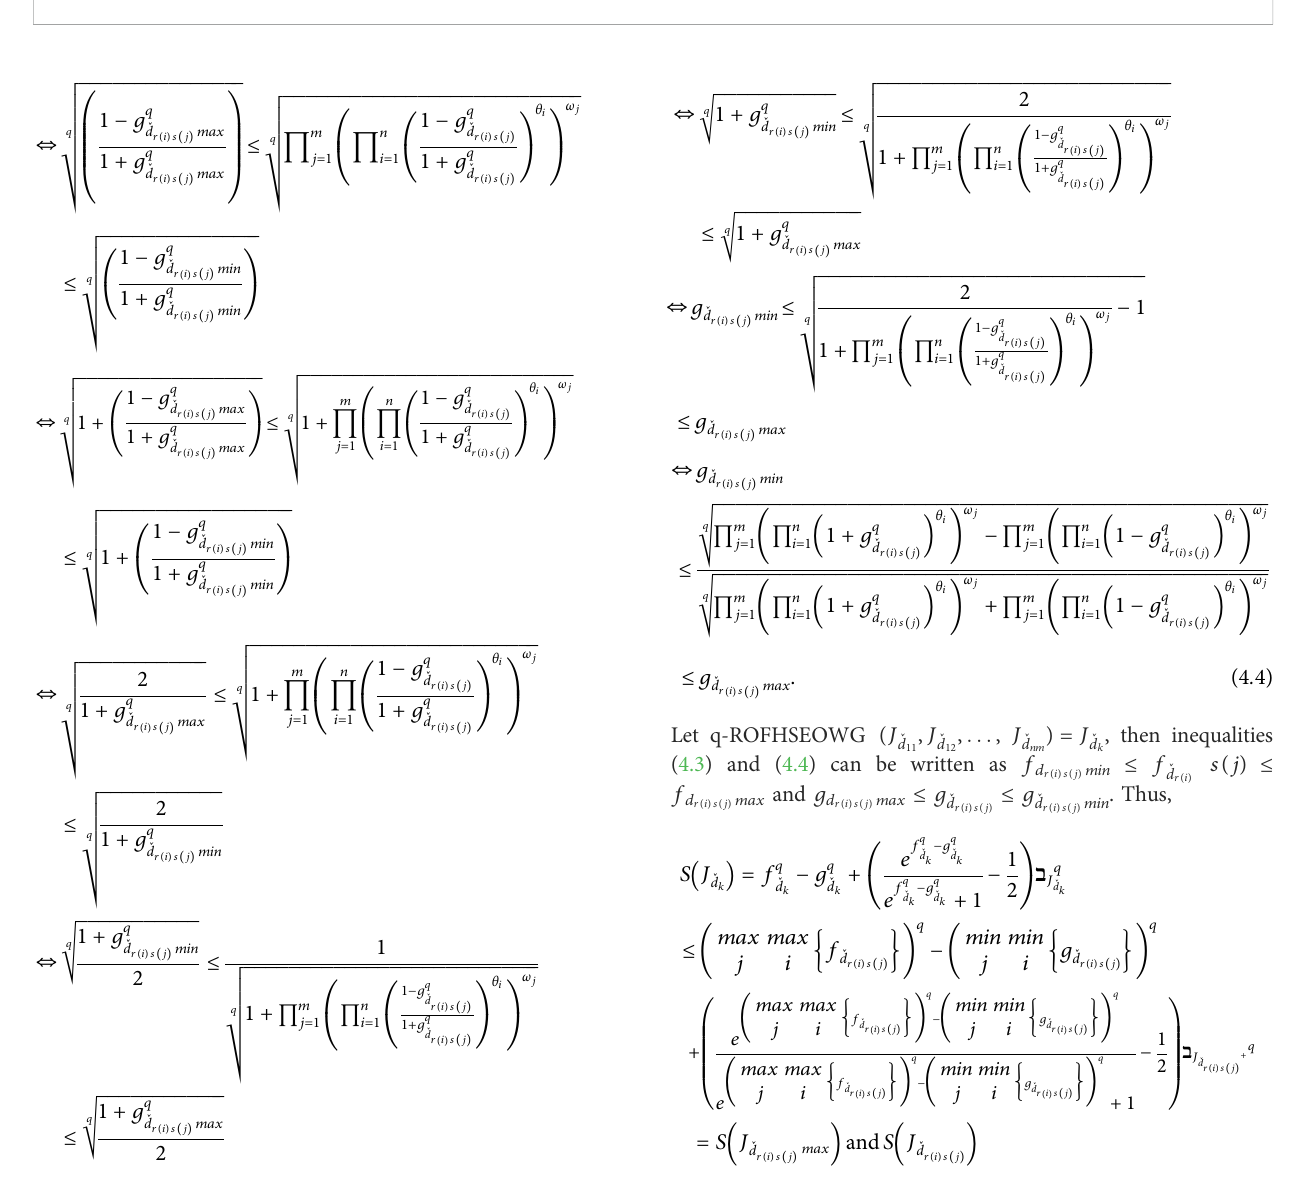
FIGURE 5 Thermochemical heat storage technique [Figure 1 (Mette et al.,